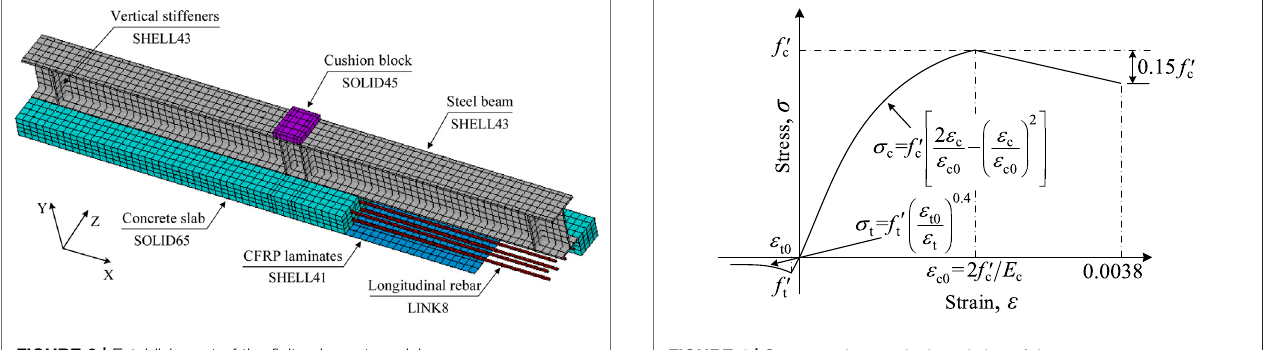
FIGURE 3 | Establishment of the fi nite element model. FIGURE 4 | Stress-strain constitutive relation of the concrete.